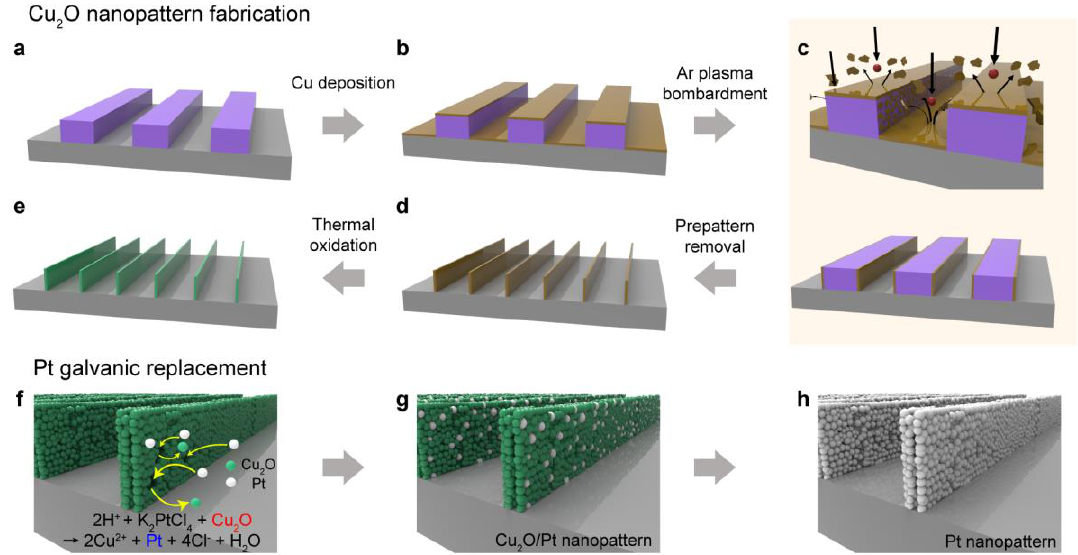
Figure 1. Schematic illustration of fabrication of Pt-functionalized high-resolution Cu 2 O nanopattern. ( a ) The PS prepattern was transferred from the PDMS mold. ( b ) The target metal (Cu) was deposited onto the prepattern. ( c ) By low-energy plasma bombardments, the deposited metal was widely sputtered onto the side wall of the prepattern, resulting in polycrystalline Cu walls. ( d ) The prepattern residue was removed by RIE and ( e ) the ultra-thin Cu line pattern was oxidized by thermal annealing. ( f ) To functionalize the Cu 2 O surface with Pt, the prepared channel was immersed in a Pt precursor solution. ( g ) The electrons were transferred from Cu 2 O to Pt ions, resulting in the Pt-decorated Cu 2 O nanopattern. ( h ) In case of an excessive galvanic reaction, the Cu 2 O baseline channel was completely converted into Pt.